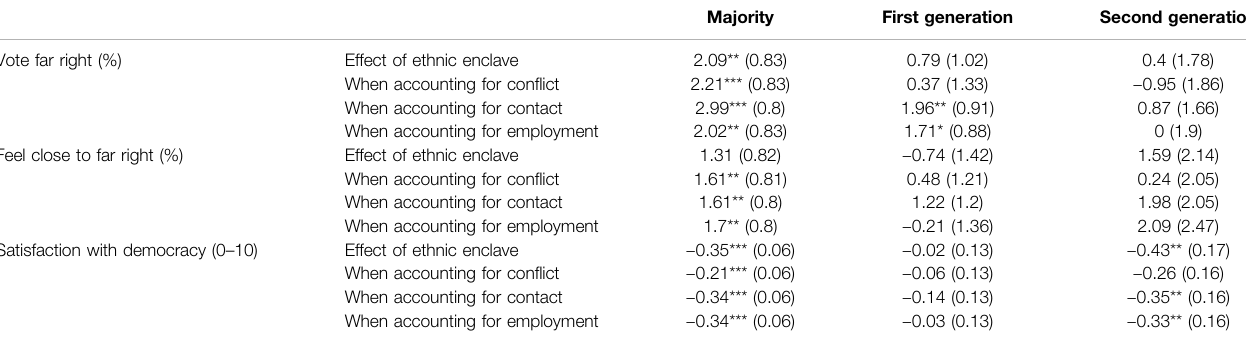
TABLE 5 | Con fl ict, contact, and employment status mediating the relationship between ethnic enclaves and voting and political behavior.